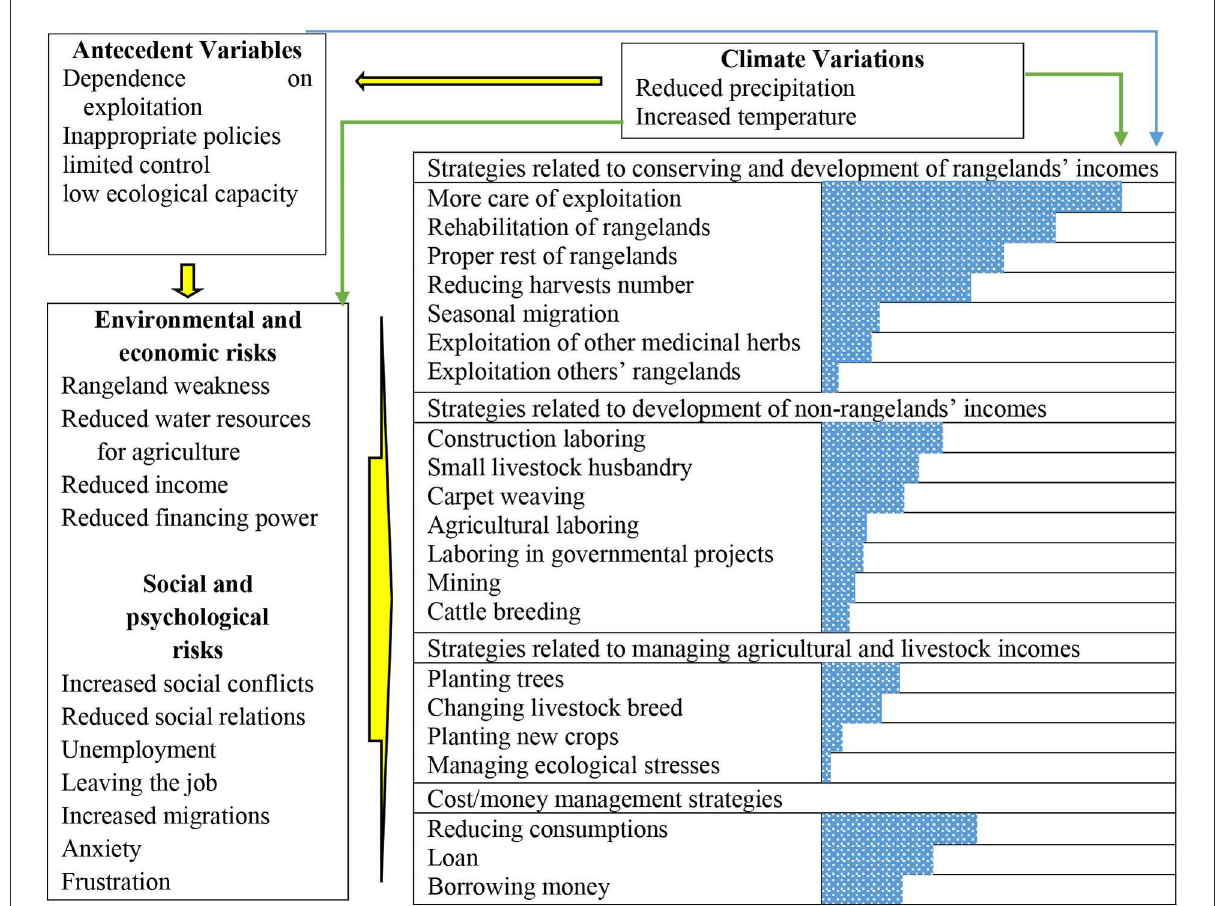
FIGURE4 Conceptual model of adaptation to climate variability and its pathway based on awareness and perceptions of medicinal plant